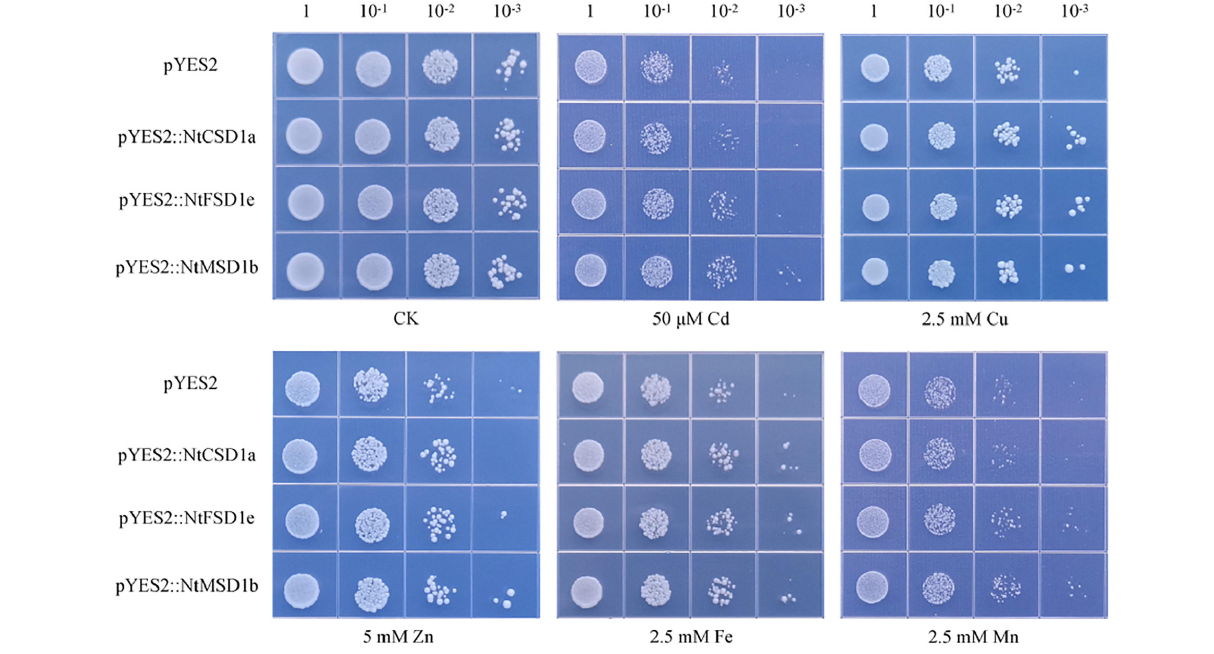
the overexpression of NtSOD genes in the mutant (cid:49) yap1 yeast effectively enhanced the resistance of yeast to heavy metal